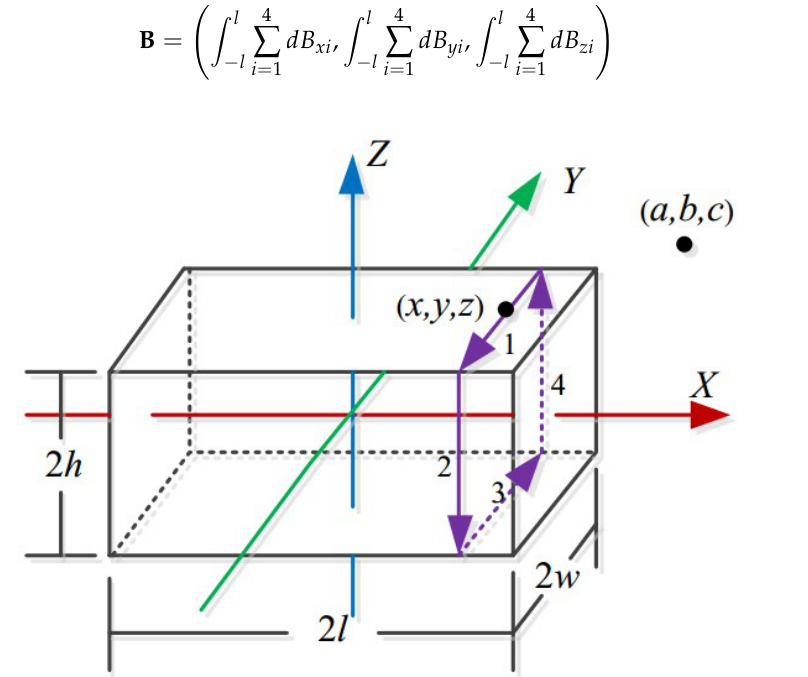
Figure 3. Modeling of the rectangular coil. The coordinate system is based on the coil. The X -axis is along the length of the coil and the origin of the coordinate is at the center position of the coil. The model is based on the Biot–Savart Law and the superposition principle. The direction of the current I is different in the four different